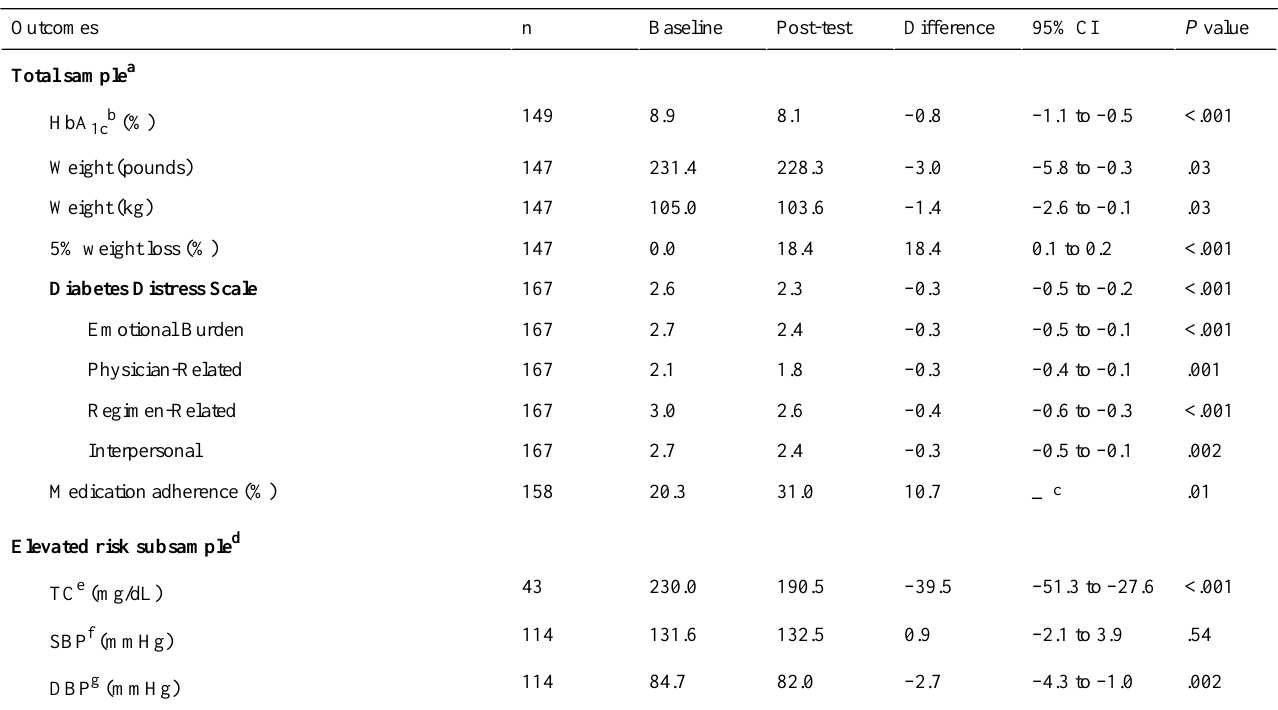
Table 2. Baseline to post-test changes in clinical outcomes (N=167).